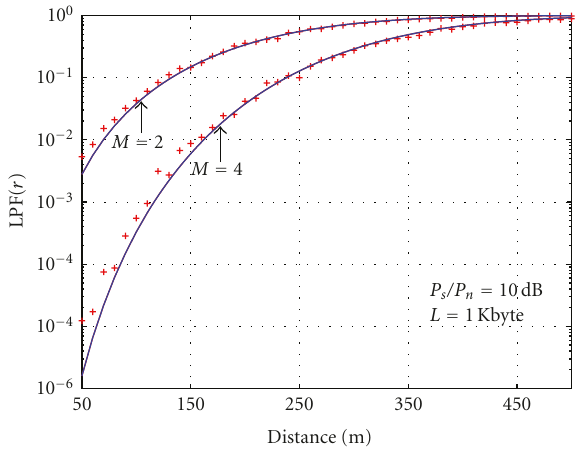
Figure 9: Loss probability due to fading for a given distance.